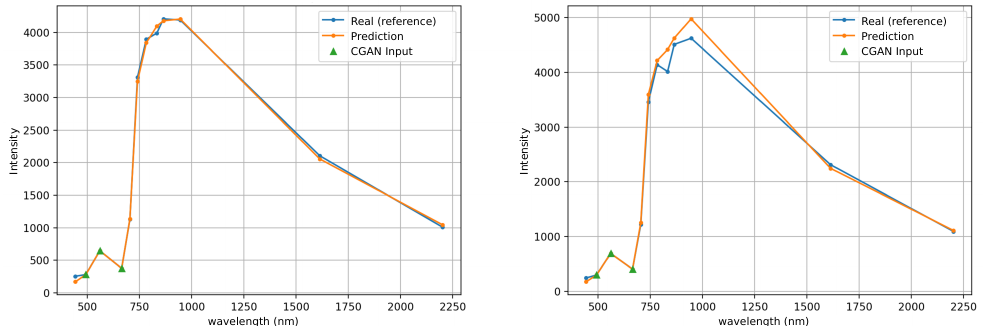
Figure 13. Average intensity of the pixels (( left ) plot) and wavelength of a random pixel (( right ) plot) of the multispectral patch of the